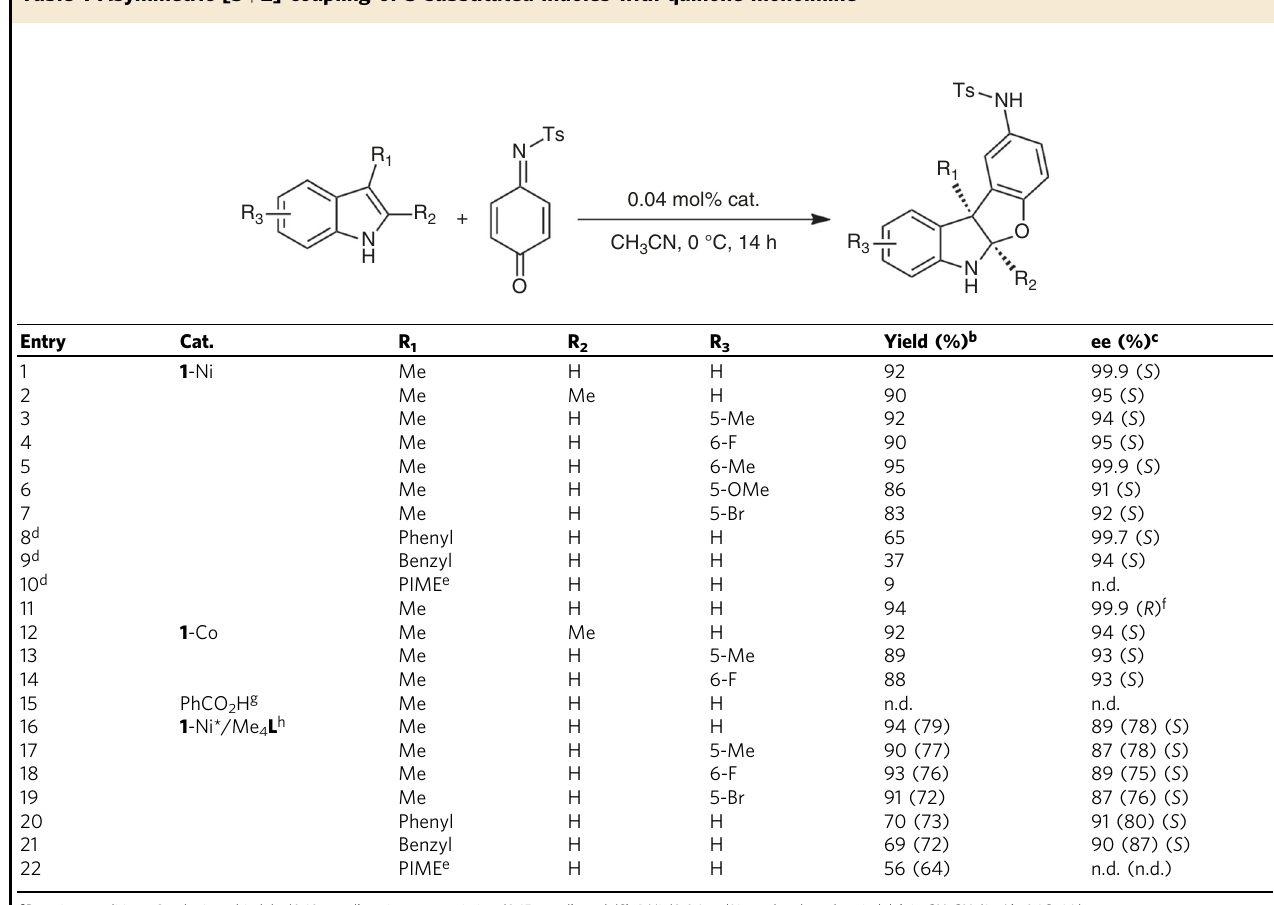
Table 1 Asymmetric [3 + 2] coupling of 3-substituted indoles with quinone monoimine